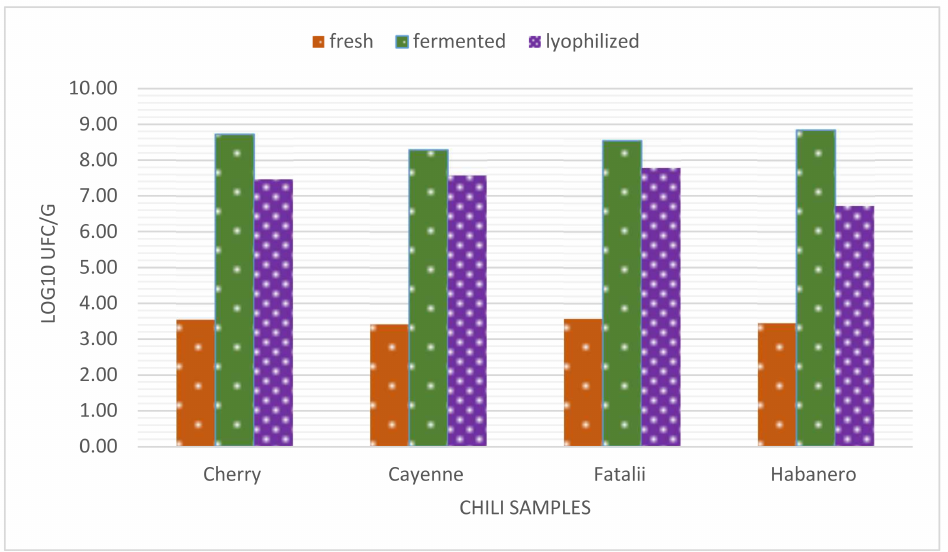
Figure 2. Diagram representing viability of LAB in peppers of different pungencies in different stages (fresh; fermented 21 days and freeze-dried). In this case, spontaneous fermentation was carried out for a maximum of 21 days.